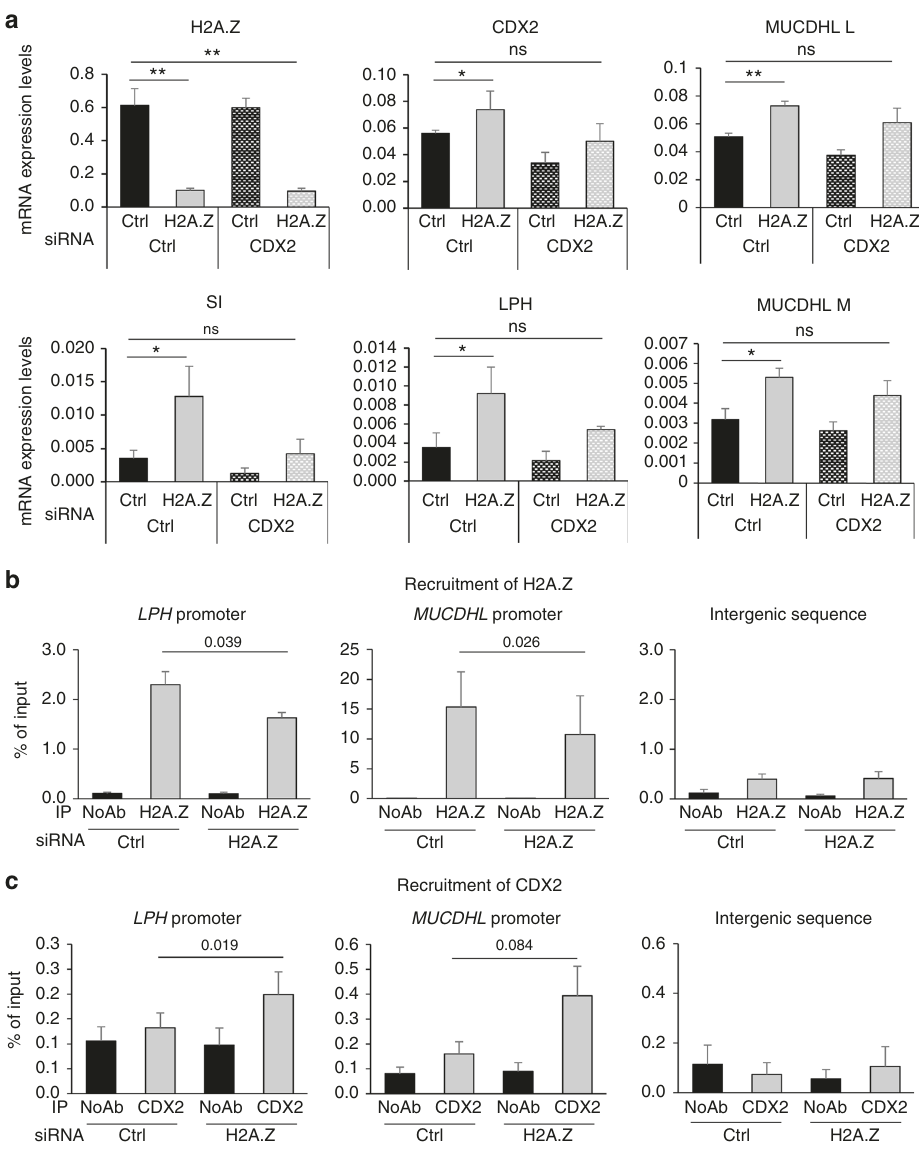
Fig. 5 Epistatic relationship between H2A.Z and CDX2. a Caco-2/15 cells were transfected using siRNA targeting CDX2 mRNA or control, upon or not siRNA-mediated H2A.Z depletion. 72 h later, total RNA was extracted and subjected to RT-qPCR analysis for the expression of the indicated genes (calculated relative to β 2m mRNA level). The mean and standard error are shown ( n = 3 independent experiments). Statistical analysis was done using Student ’ s t -Test (* p < 0.05; ** p < 0.02 vs control siRNA). b Caco-2/15 cells were transfected using siRNA targeting H2A.Z or control, as indicated. 72 h later, ChIPs were performed using an H2A.Z antibody or no antibody as a control (No Ab). The amount of LPH or MUCDHL promoters, or an intergenic sequence were analyzed by qPCR, and the percentage of input was calculated. The mean and standard error are shown ( n = 3 independent experiments). Statistical analysis was done using unilateral Student ’ s t -Test. c Same in b for CDX2 ChIP